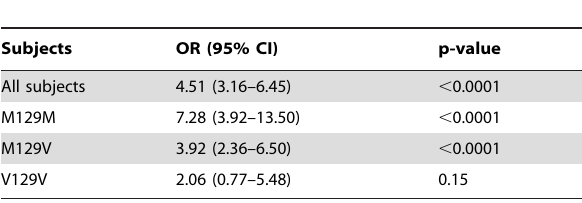
Table 2. Odds ratios for the association between Alzheimer’s disease and APOE e 4 carriers (vs. APOE e 4 non-carriers) among different strata defined by PRNP codon 129